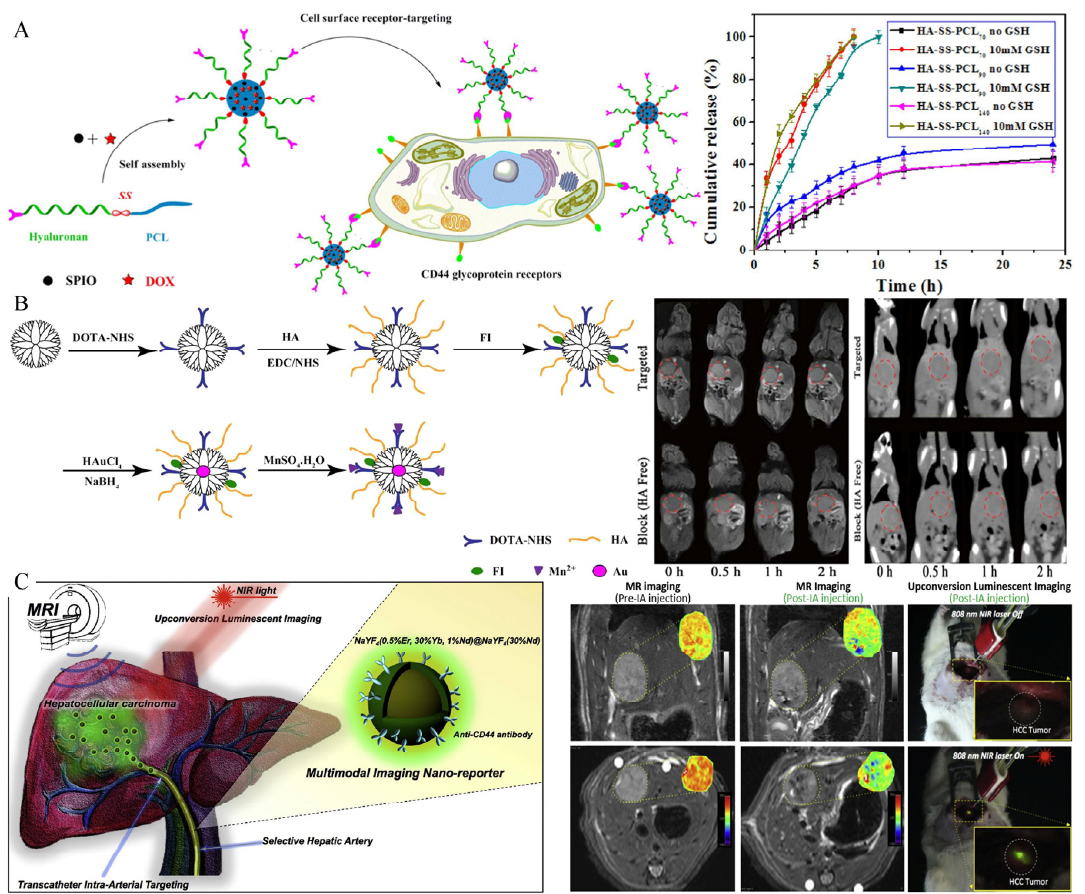
Figure 13. ( A ) Preparation of glutathione-responsive micelles loaded with doxorubicin and SPIONs, and 100% release of doxorubicin in reduction state. Reproduced with permission Ref. [88]. Copyright 2019 Elsevier. ( B ) Preparation and imaging of MRI/CT dual-mode probe. Reproduced